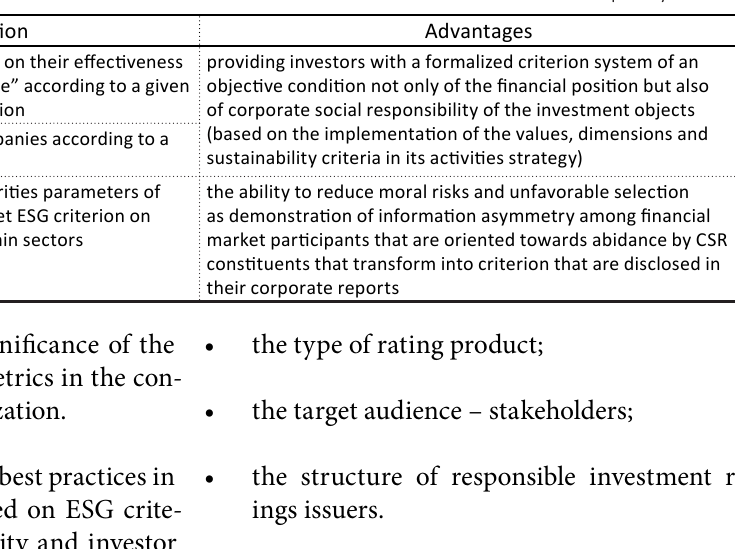
Table 2. Key benchmarks in the ESG investment